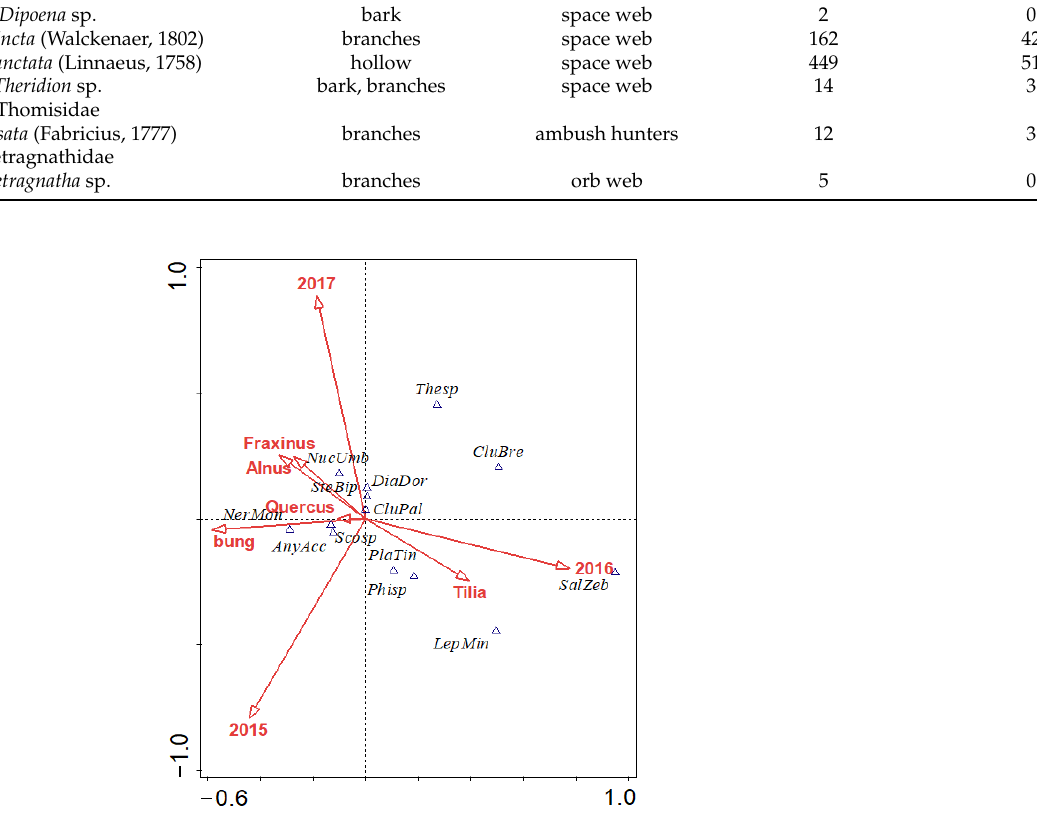
Figure 1. Spider species in relation to the sampling year, tree species, and bunging of nesting